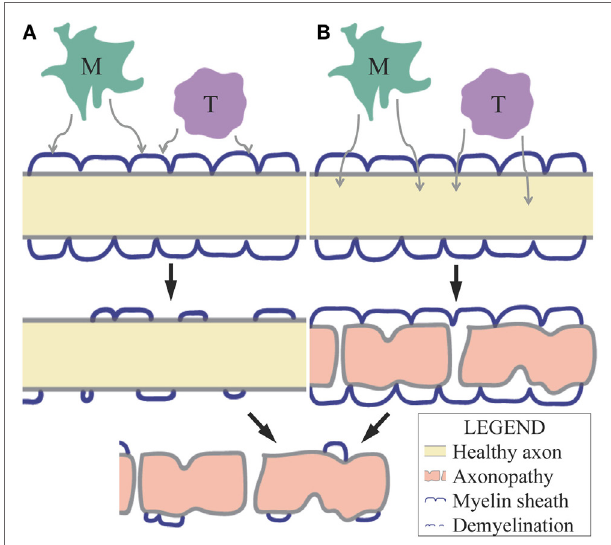
FiGURe 1 | (A) The outside-in model of axonal degeneration predicts that demyelination occurs before axonopathy due to myelin-degenerative factors released by inflammatory cells (M = macrophages/microglia, T = T lymphocytes) within the CNS. The loss in protection and trophic support by myelin results in axonal damage in this model. (B) The inside-out model of axonal degeneration or Wallerian degeneration predicts that axonopathy occurs before demyelination due to neurotoxic factors released by inflammatory cells within the CNS. These factors may diffuse through myelin or pass through the nodes of